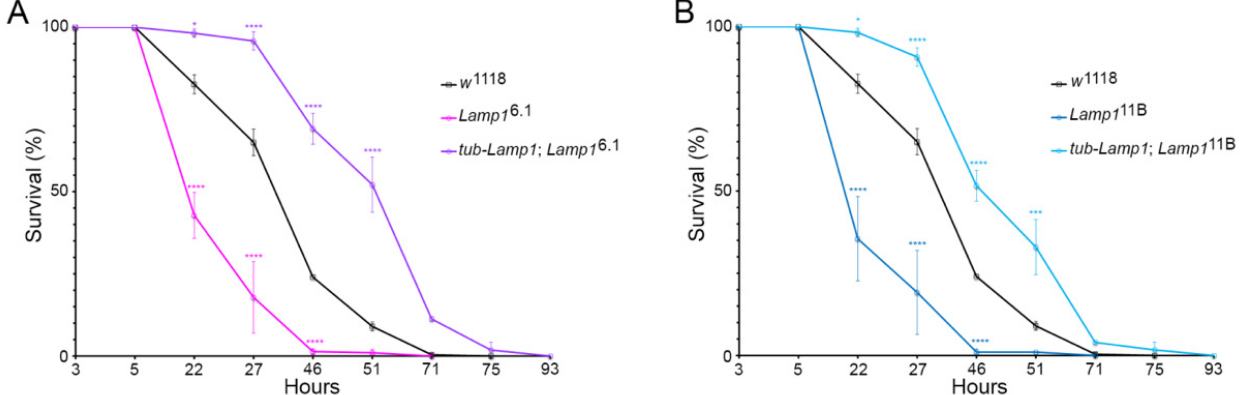
Figure 1. Drosophila Lamp1 mutants are highly sensitive to oxidative stress. ( A , B ) Non-virgin 7-day old Lamp1 6.1 or Lamp1 11B mutant and w 1118 control female flies were exposed to 20 mM paraquat and the percentages of surviving flies were counted at each indicated time point. Ubiquitous expression of Lamp1 with a tub - Lamp1 construct rescued the high paraquat sensitivity of the Lamp1 mutants and conferred further oxidative stress resistance compared to wild-type controls. Detailed genotypes of the strains are reported in Table S1. Two-way ANOVA with Tukey’s post-hoc test (**** p < 0.0001; *** p < 0.001; * p < 0.05). Error bars represent SEM.